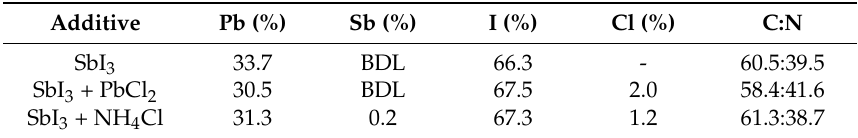
Figure 6. Optical microscope images of CH 3 NH 3 Pb(Sb)I 3 (Cl) cells. The additives are ( a ) none; ( b ) SbI 3 ; ( c ) SbI 3 with PbCl 2 ; and ( d ) SbI 3 with NH 4 Cl, respectively. Table 3. Measured compositions of TiO 2 /CH 3 NH 3 Pb(Sb)I 3 (Cl) cells. BDL means below detection limit.